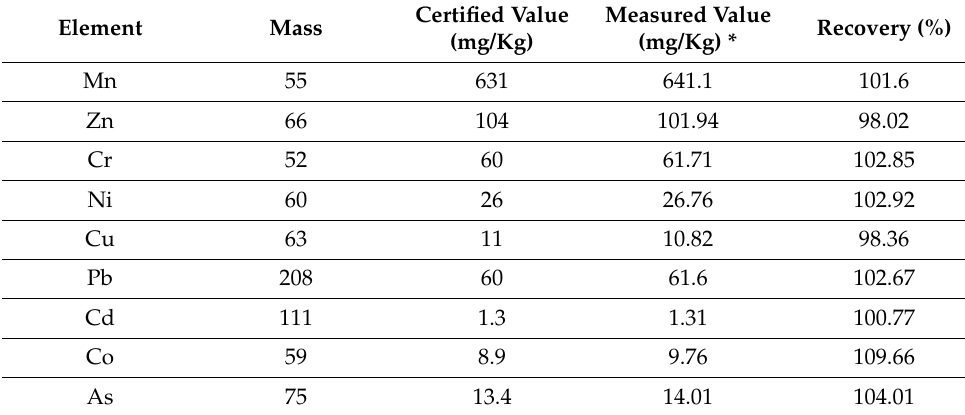
Table 1. The accuracy and precision of the analytical method applied to the multi-element determi- nation of soil